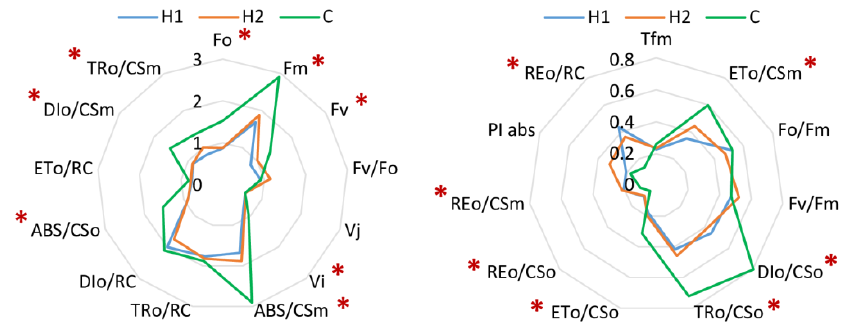
Figure 2. Physiological indexes of plants grown in different soils; red asterisks (*) marks indexes with significant differences between soils ( p < 0.05). The data of different metrics were normalized for optimal presentation; original data can be found in supplementary Table S1.